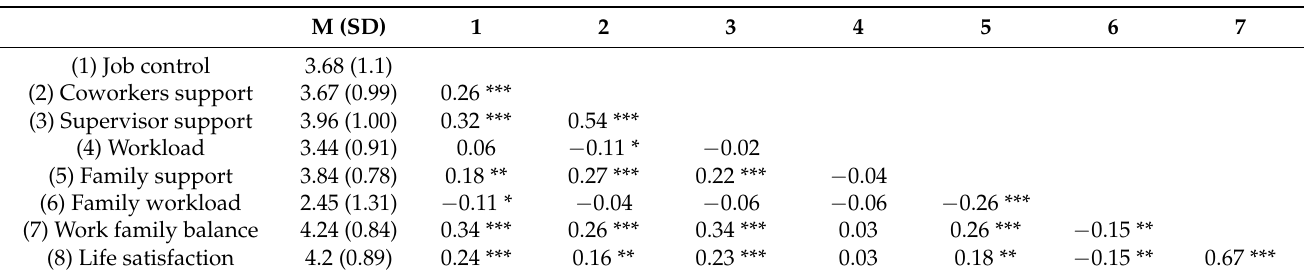
Table 1. Study variables’ descriptive statistics and zero-order correlations.